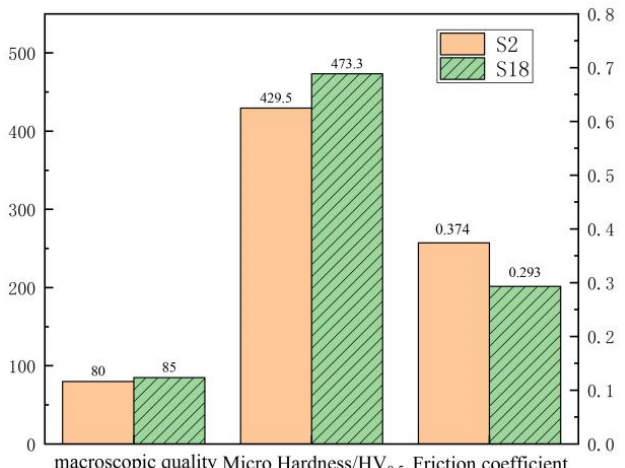
Figure 11. Comparison of the response values of S2 and